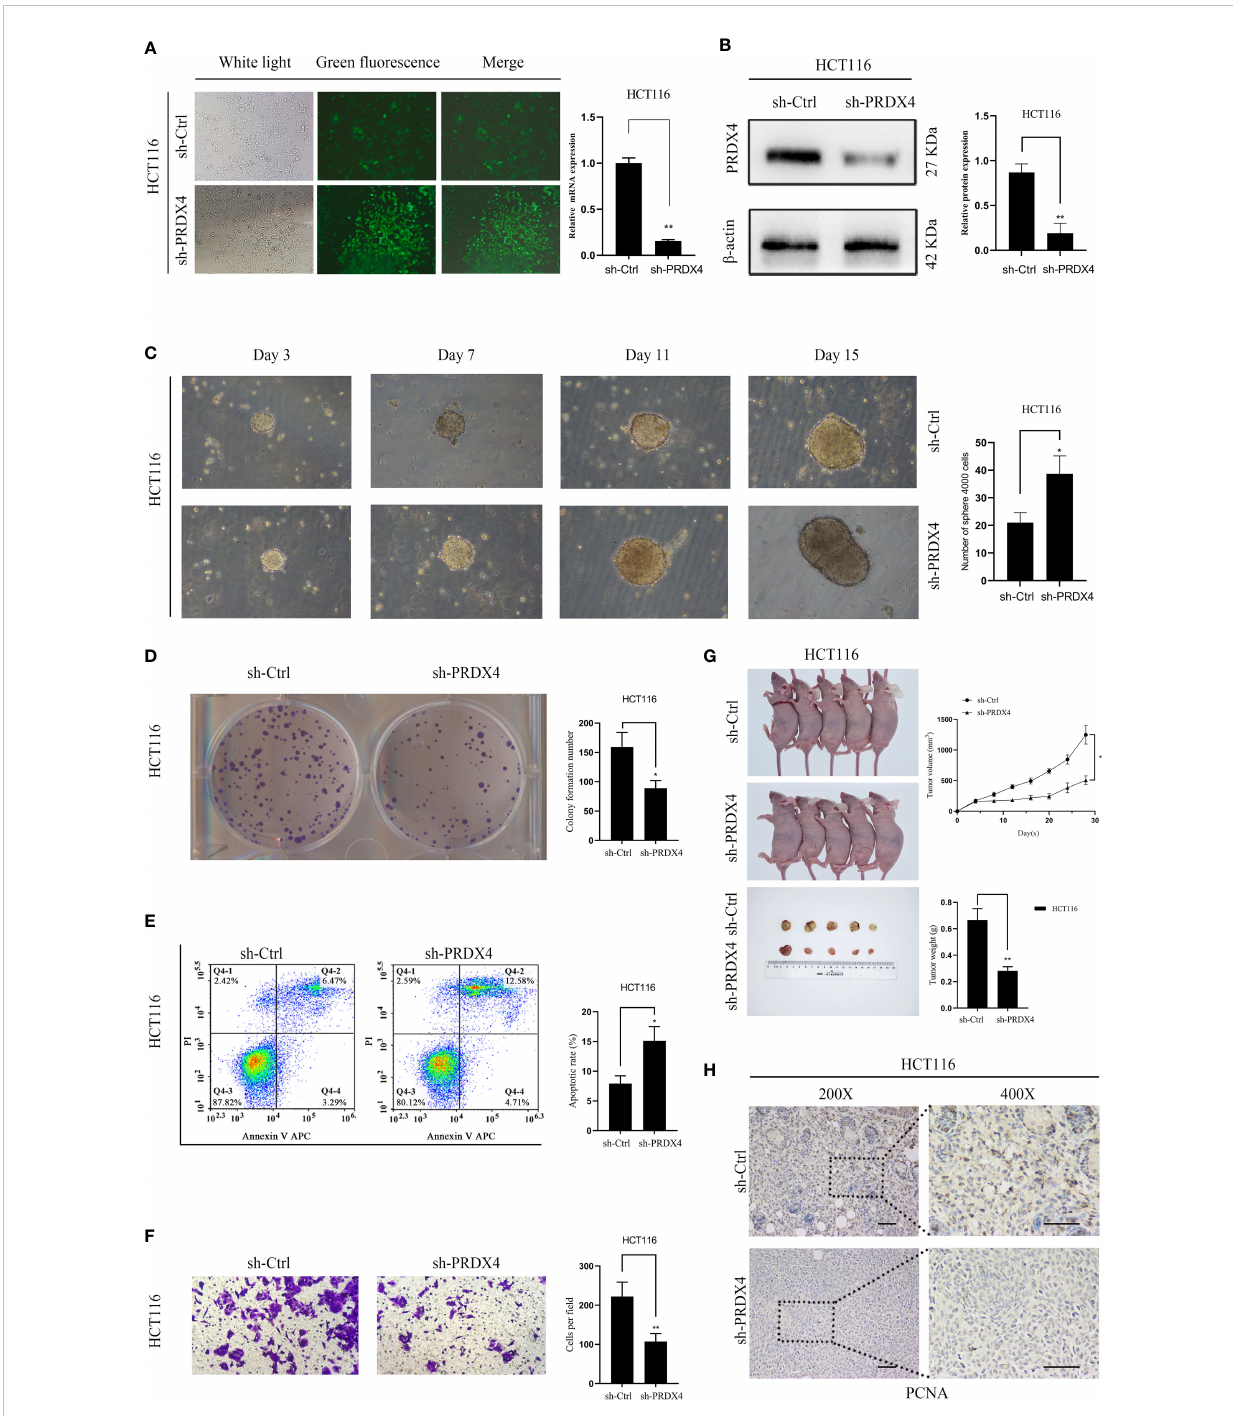
FIGURE 12 Knockdown of PRDX4 inhibits CRC cell proliferation and invasion and promotes CRC cell stemness and apoptosis. (A) The transfection ef fi ciency was observed by fl uorescence microscopy and detected by RT-qPCR. (B) Western blot was used to validate the expression of PRDX4 protein in HCT116 cells transfected with shRNA. (C) Sphere formation assay of HCT116 cells showing that knockdown of PRDX4 promoted cell stemness. (D) Colony formation assay of HCT116 cells showing that knockdown of PRDX4 inhibited cell proliferation. (E) Flow cytometry results showing that knockdown of PRDX4 promoted apoptosis in HCT116 cells. (F) Transwell assay of HCT116 cells showing that knockdown of PRDX4 inhibited cell invasion. (G) Knockdown of PRDX4 inhibited tumor growth of HCT116 cells in vivo . (H) Images of IHC staining of PCNA in xenograft tumors. scale bar, 50 m m. * P < 0.05, ** P < 0.01. IHC, immunohistochemical; PCNA, proliferating cell nuclear